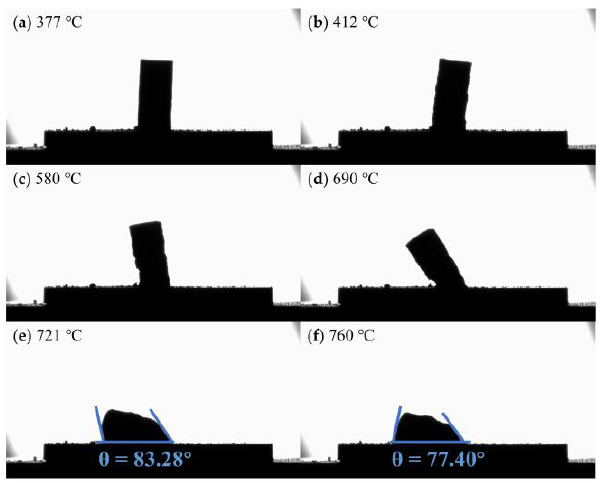
Figure 4. Images of the contact angle between flux #4 and alumina plate at different temperatures: